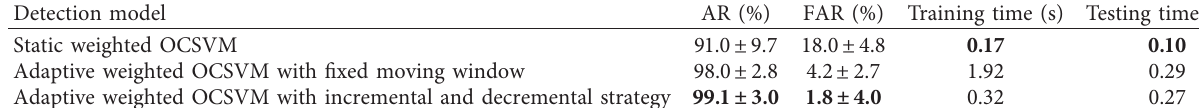
Table 1: Comparison of different weighted OCSVM methods.